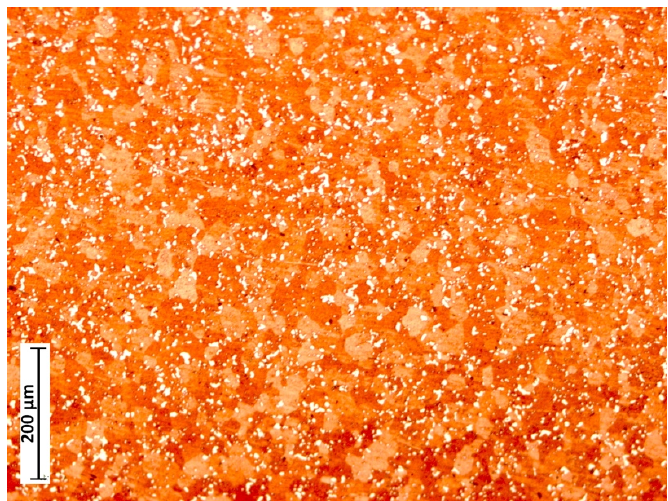
Figure 12. Microstructures after chemical etching of molybdenum powder with a high carbon content after sintering at 1900 °C under 70 MPa pressure for 30 min of holding.